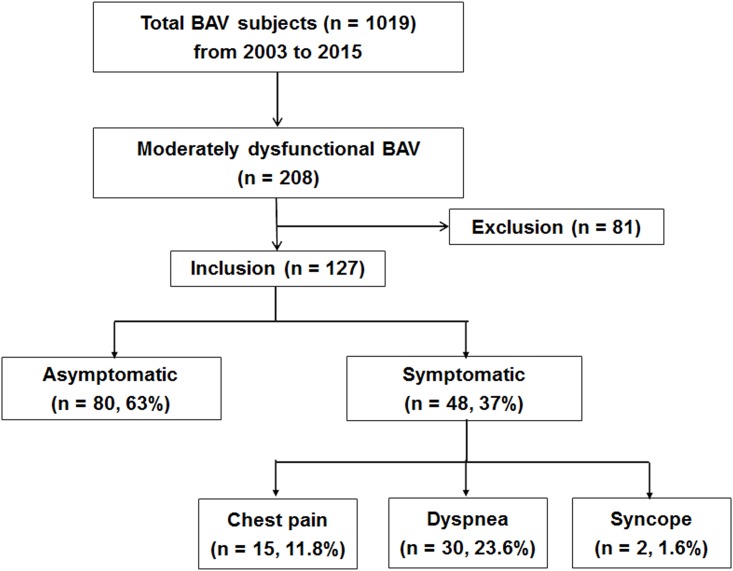
Description of the study population.